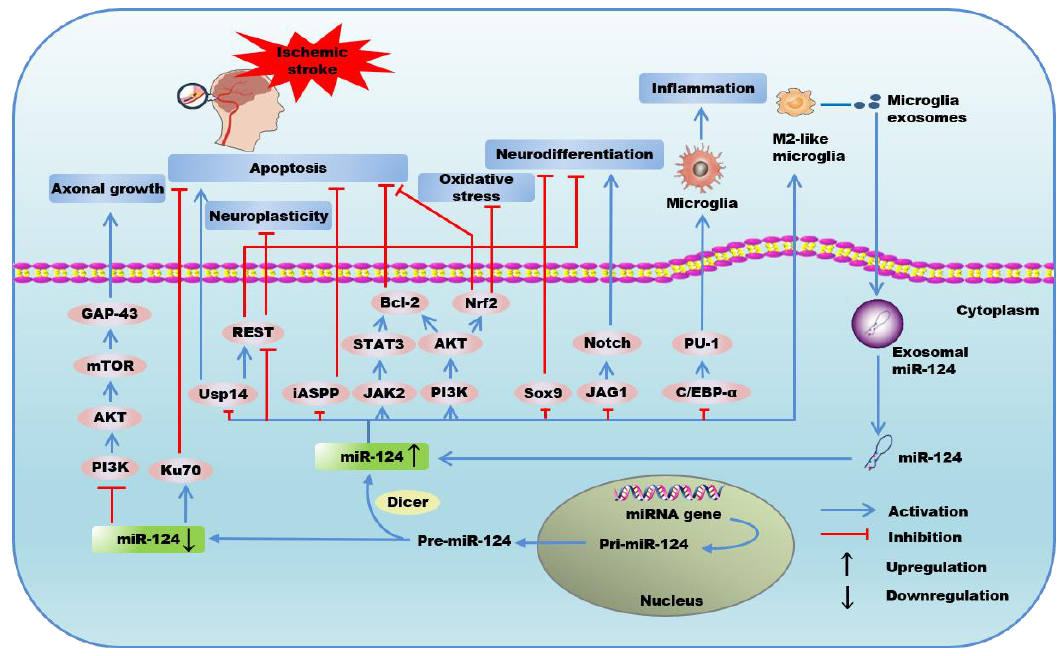
Figure 1. The possible mechanisms of the regulation of microRNA-124 in ischemic stroke.